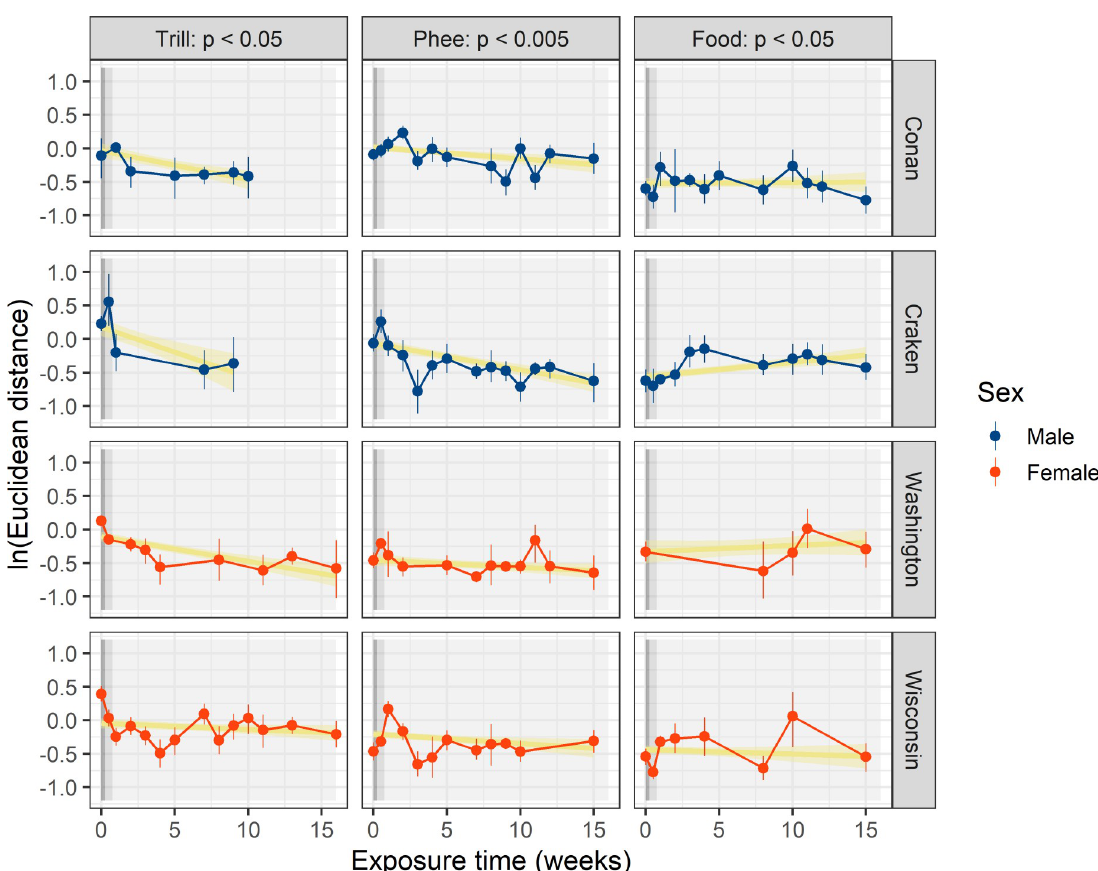
Fig 3. Social accommodation over time. Changes in vocal distance over time relative to the ZH population for the four translocated animals (rows), separately for each call type (columns). Dots represent weekly averaged values, calculated on a minimum of five recordings per individual per call type, with associated 95% (bootstrapped) confidence intervals represented by vertical error lines. Solid dark-yellow lines with shaded 95% confidence intervals represent the general pattern in change over time. Vocal distance decreases significantly over time in trill- and phee calls, and slightly increases in food